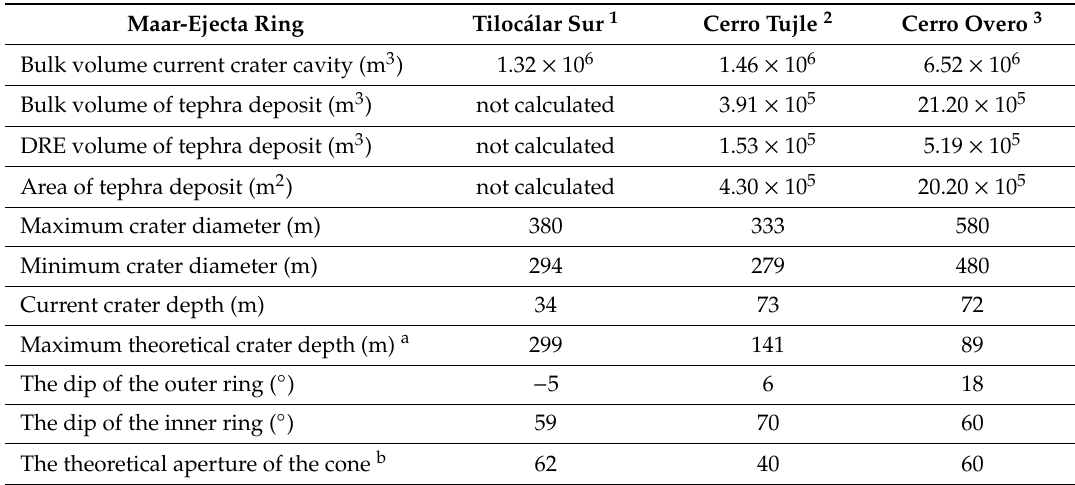
Table 2. Morphometric characteristics of Tiloc á lar Sur, Cerro Tujle, and Cerro Overo maars.